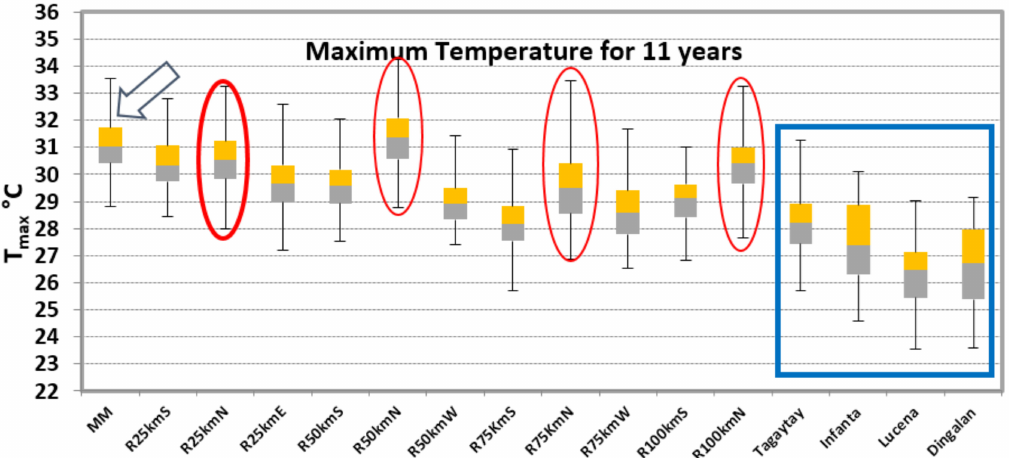
Figure 6. Spatial variation of temperature for the period 2000–2010. MM stands for Metro Manila (indicated by the arrow) while encircled are the north sites, and the blue box represents the elevated and MCC Type